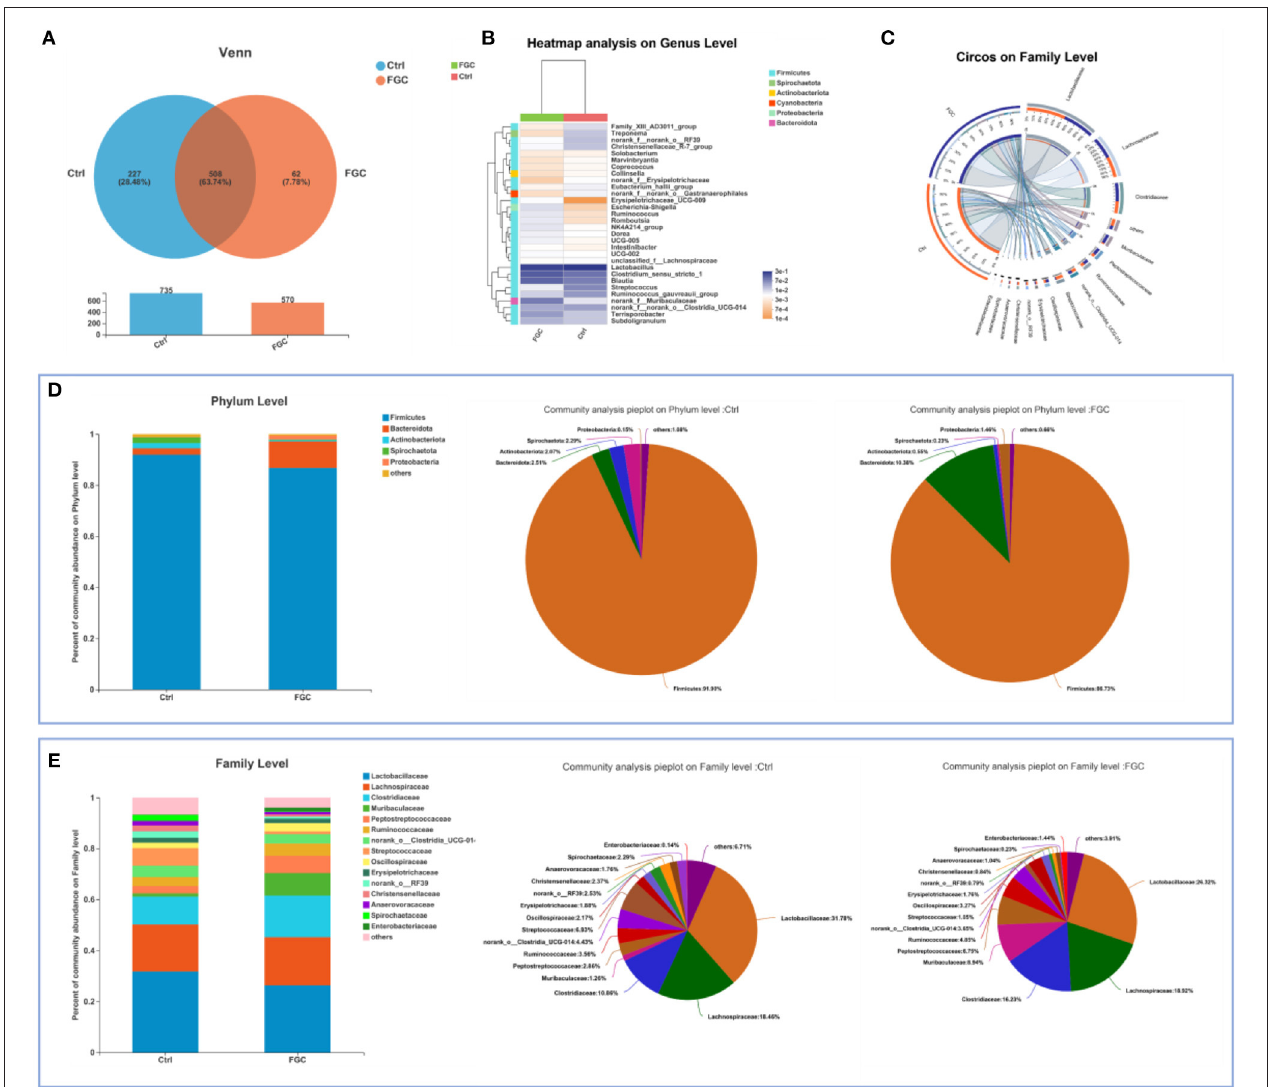
FIGURE 5 | Overview of fecal microbial composition of 14d-piglets. (A) Venn diagram. (B) Heatmap at genus level. (C) Circos diagram at family level. (D) Barplot and pieplot at phylum level. (E) Barplot and pieplot diagram at family level. Ctrl, corn-soybean basal diet; FGC, corn-soybean basal diet with 2,000 mg/kg ferrous glycine chelate. N =